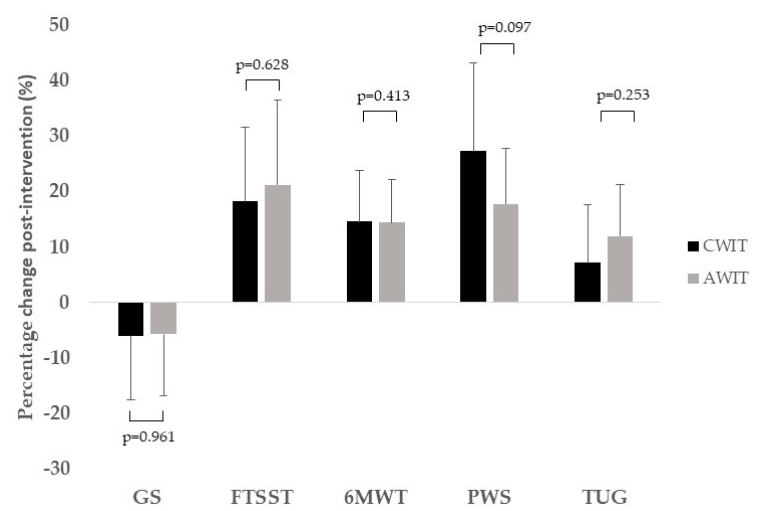
Figure 1. Percentage of change in physical function measurements following CWIT (solid bar) and AWIT (gray bar). GS indicates grip strength; FTSST, lower limb strength (time in seconds); 6MWT, 6 min walk test (m); PWS, preferred walking speed (time in seconds); TUG, timed up and go (time in seconds); CWIT, continuous walking interval training; AWIT, accumulated walking interval training.